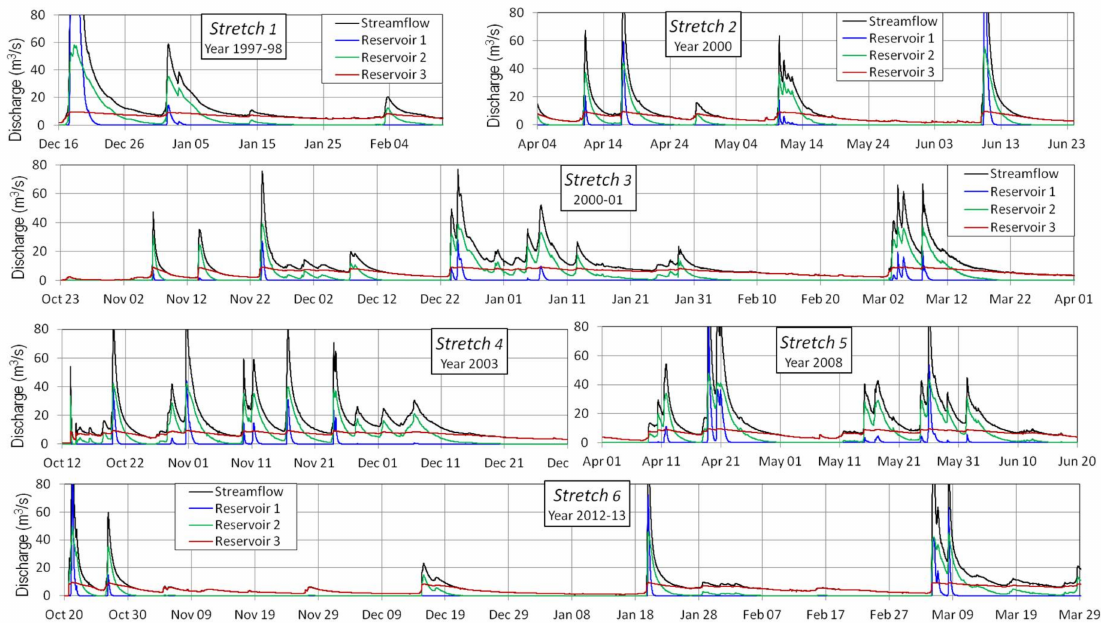
Figure 6. Flow separation for the six stretches selected of the time series with the 3R